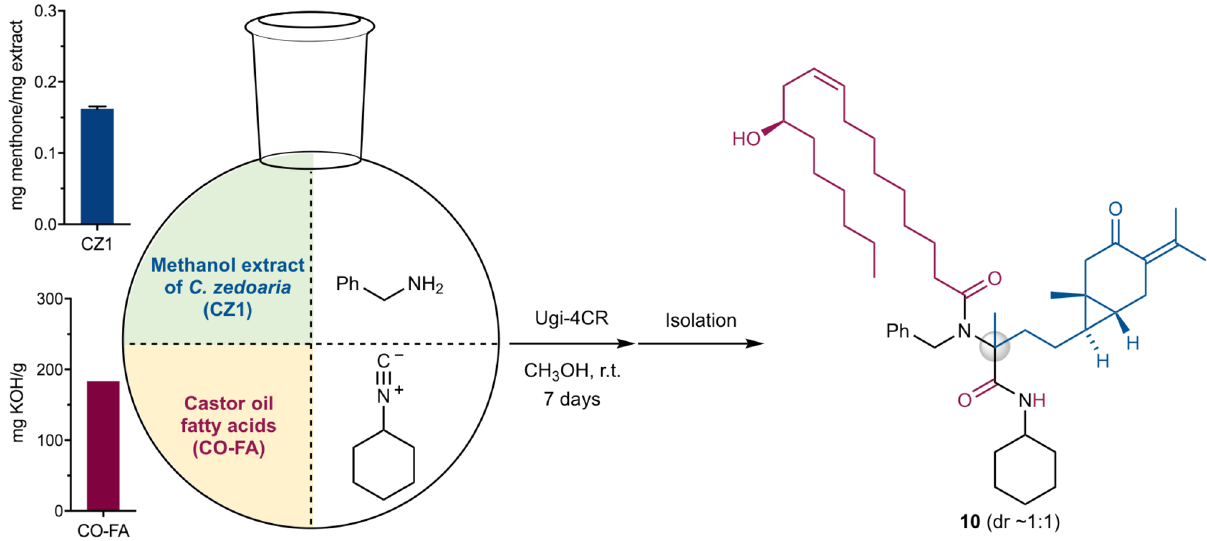
Figure 5. Synthetic of 10 by the Ugi-4CR using a mixture of CZ1 and CO-FA in the presence of benzylamine and cyclohexyl isocyanide. The inserts show the carbonyl content of the CZ1 extract and the neutralization number of